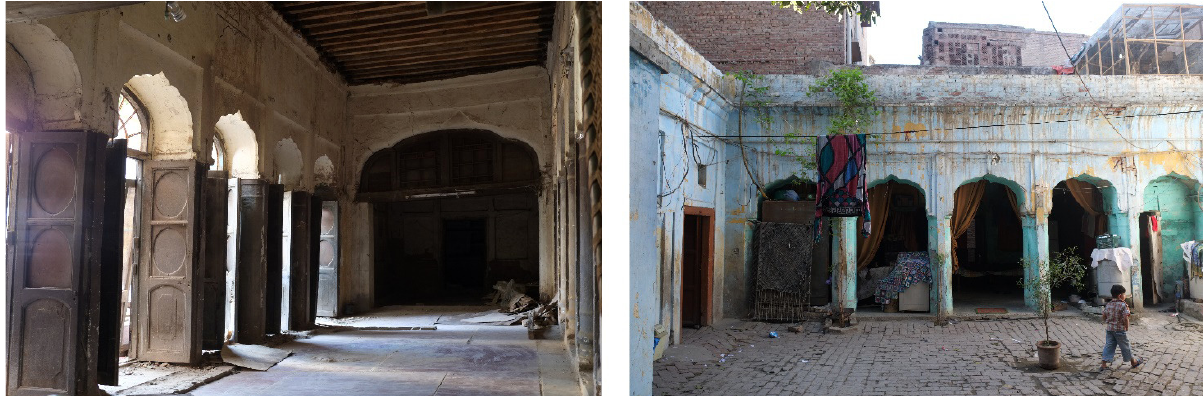
Figure 9. The interior of haveli Dina Nath on the left and courtyard on the right. Photos by Helena Cermeño